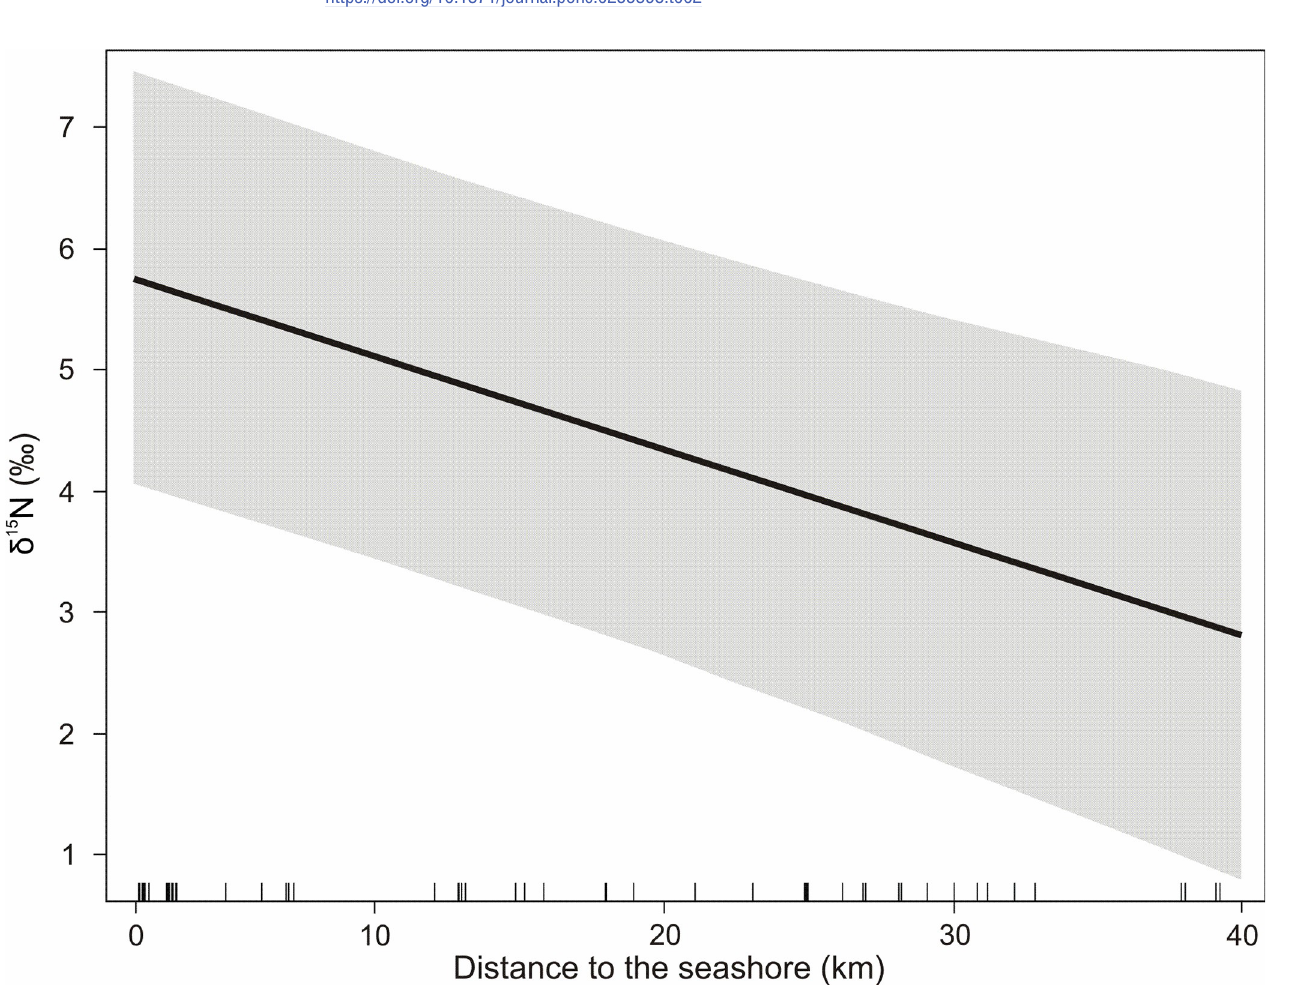
Fig 4. Relationship between distance to the seashore and δ 15 N values of bone collagen of red deer inhabiting coastal sampling sites located not more than 40 km from the sea. Grey area– 95% confidence interval of the regression line.